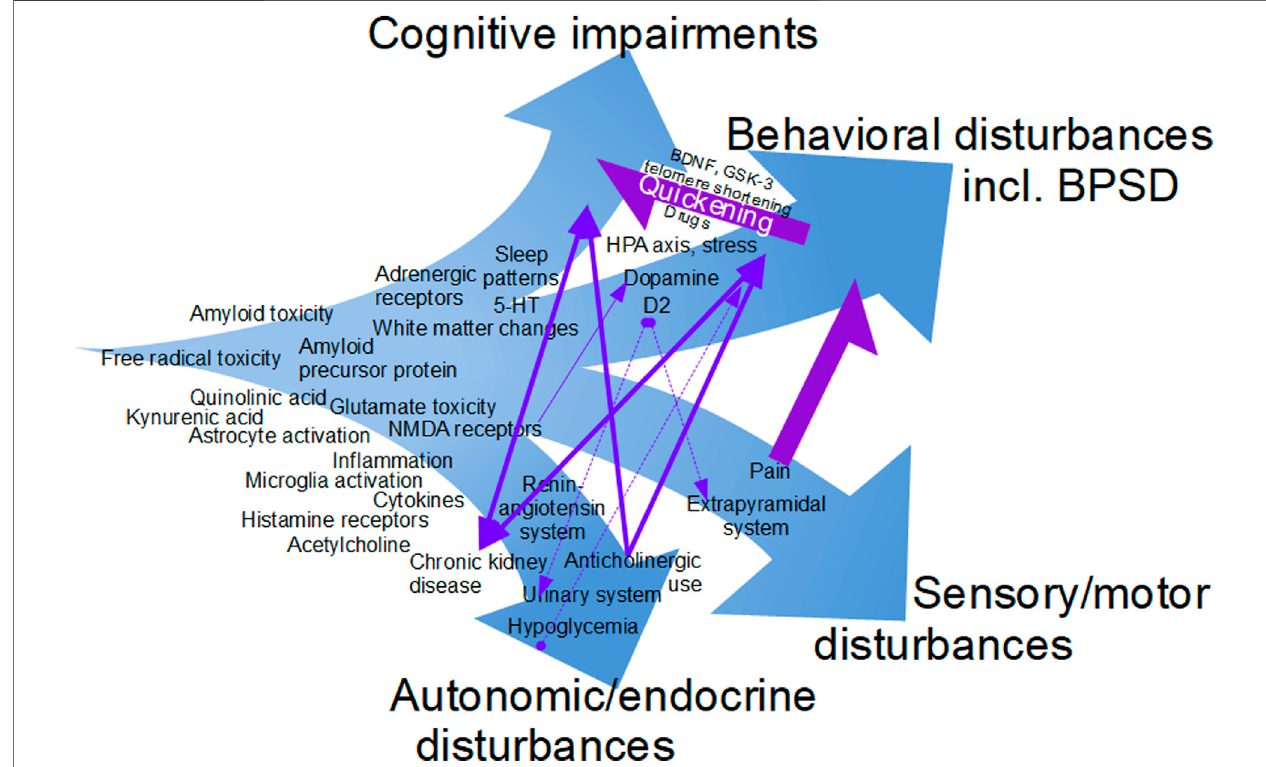
FIGURE1| Themultiplefacetsofthedementias,asgleanedfromthecontributionstothisResearchTopic.Relationshipsamongcognitiveimpairments,behavioral problems and co-morbidities such as pain and disorders of the urinary system. This fi gure is work in progress, as this version is not a complete summary of all mechanisms mentioned in the contributions or all suggestions received from the authors.